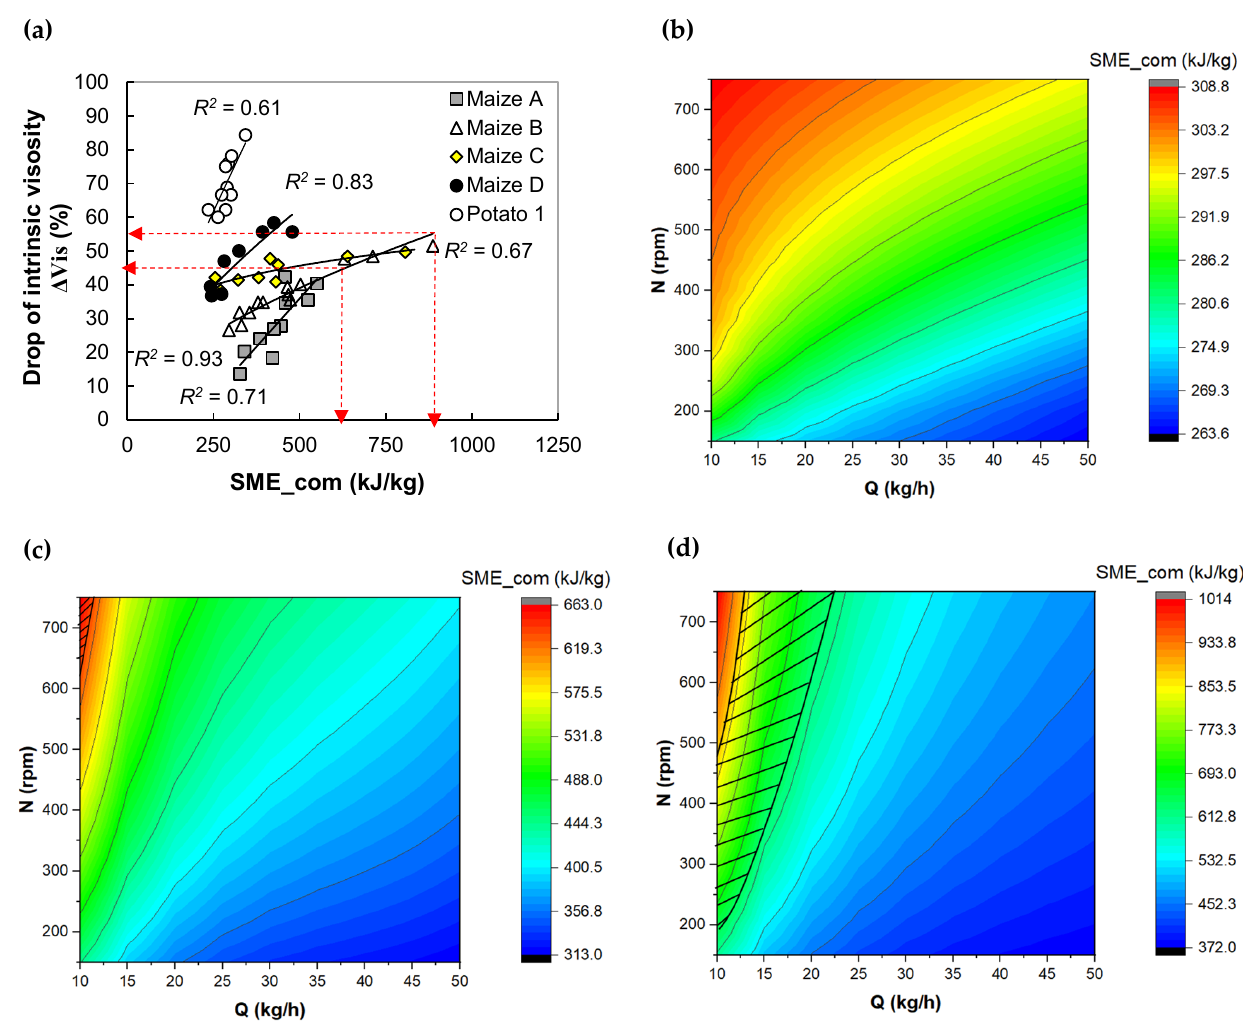
Figure 5. Application of extrusion simulation in the design of expanded maize starches having targeted starch transformation. Step 1. Relationship between the drop of intrinsic viscosity and Figure 5. computed SME (SME_com) ( a ). The arrow indicates the lower and upper limits of targeted SME_com and ∆ Vis. Step 2. Creation of extruder operating chart by 1D extrusion model. The effect of length of the left-handed element was studied on the SME_com level: ( b ) 0 mm, ( c ) 25 mm, and ( d ) 50 mm. Step 3. Determination of range of extrusion conditions (Q, N), delimited by hatched area, leading to SME_com between 625 and 875 kJ/kg according to the goal: drop of intrinsic viscosity = 50 ± 5% for feed MC = 20% and amylose content =